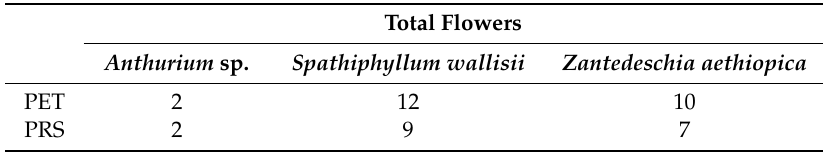
Table 2. Flower production in microcosms.